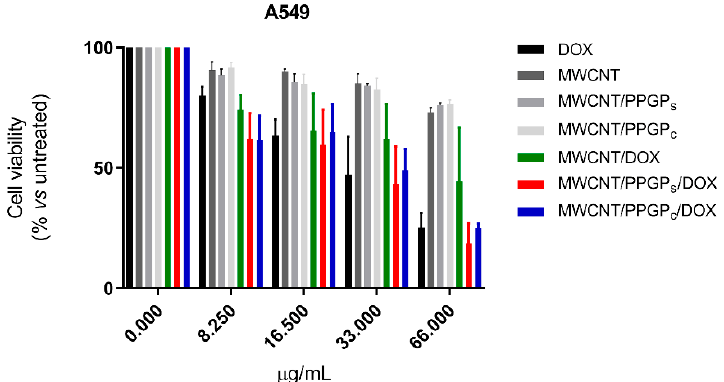
Figure 12. Cell viability (MTT assay) of A549 human melanoma cells untreated and treated for 48 h with different concentrations of free DOX hydrochloride or into both unloaded and loaded CNT. Each point represents mean ±s.e.m. of three separate experiments performed in triplicate.